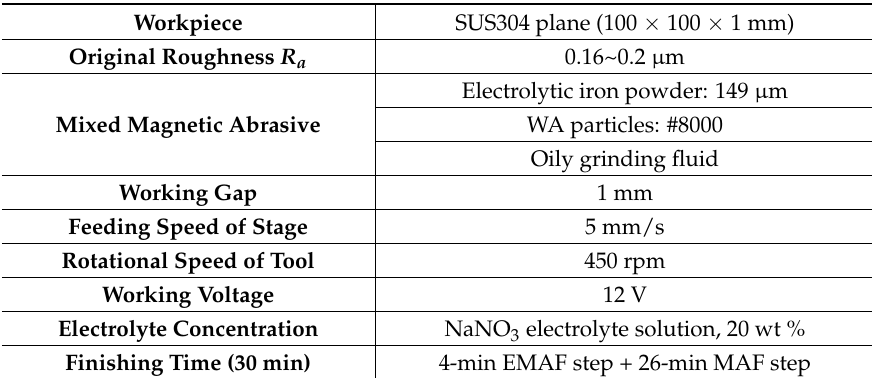
Table 2. Experimental conditions of the EMAF process.